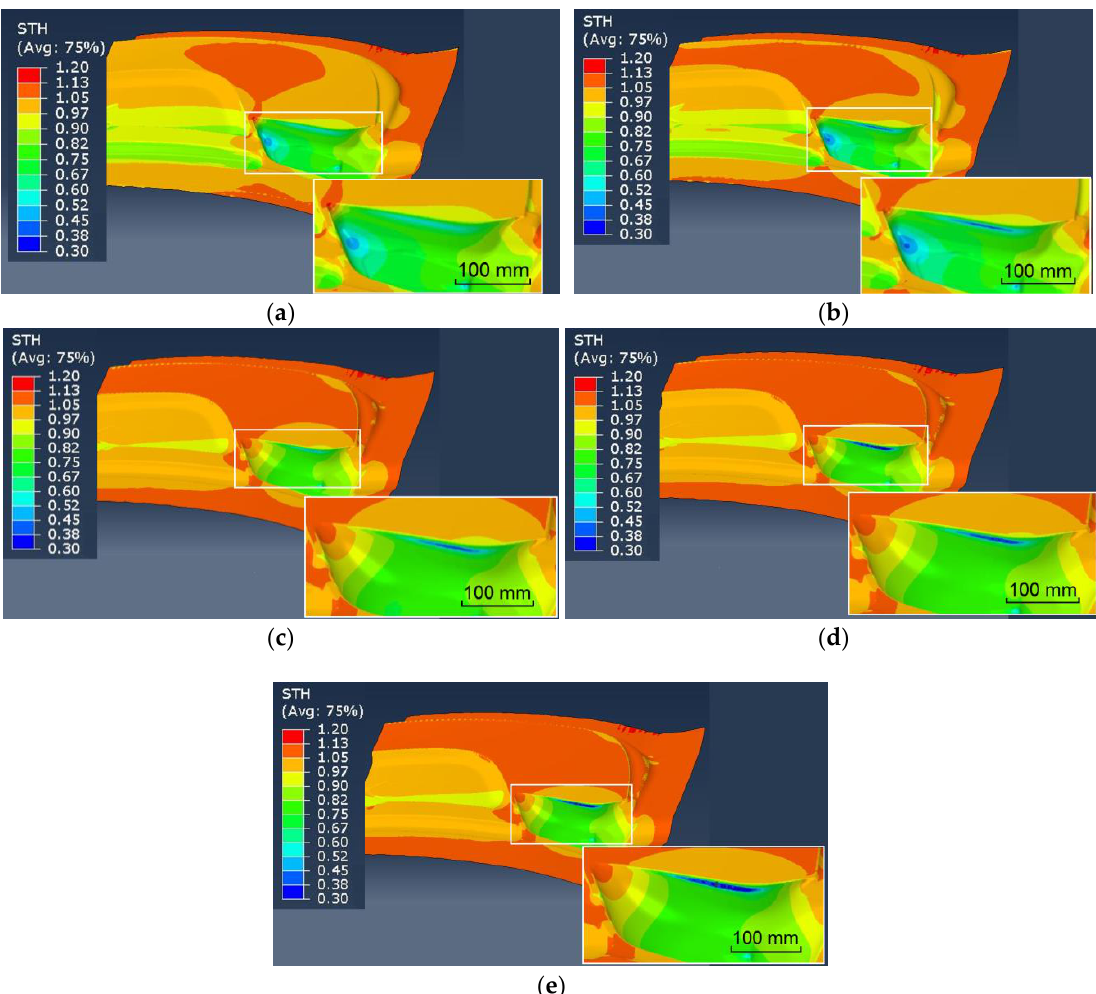
Figure 7. Predicted thickness variation within the part deformed with gas profile #1 (t: 80 s) assuming friction coefficient of: ( a ) 0.1; ( b ) 0.15; ( c ) 0.2; ( d ) 0.25; and ( e ) 0.3.